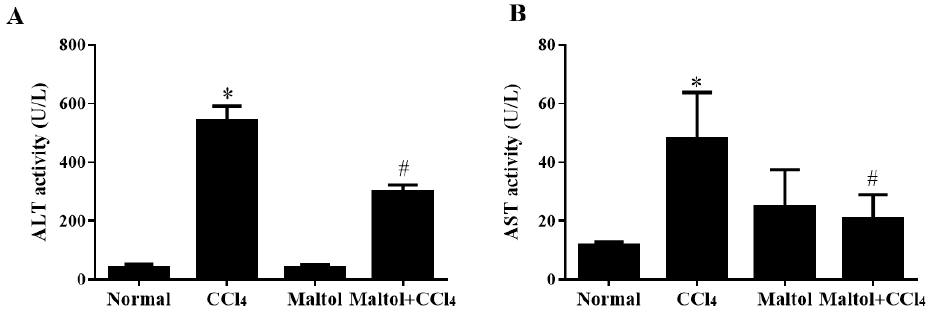
Figure 1. Pretreatment with maltol protected against CCl 4 -induced liver injury: The effect of maltol on serum levels of aspartate transaminase (ALT) ( A ) and alanine transaminase (AST) ( B ), which were provided by Nanjing Jiancheng Bioengineering Research Institute (Nanjing, China). Values are expressed as the mean ± S.D., n = 8. * p < 0.05 vs. normal group; # p < 0.05 vs. CCl 4 group.